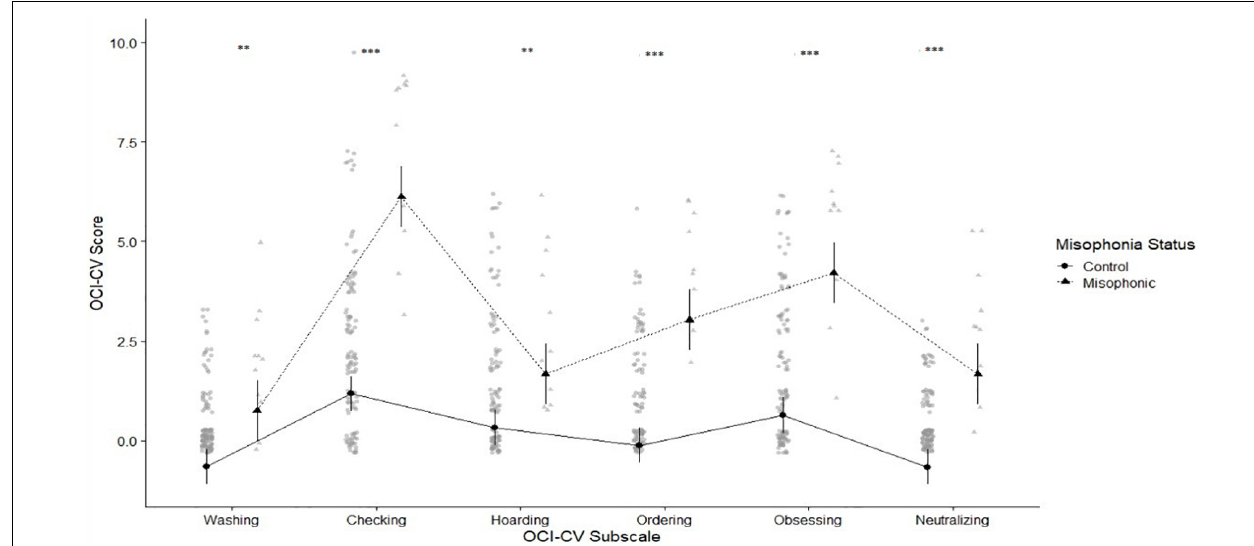
FIGURE 2 | Means plot showing greater scores for misophonics (shown in triangle) and controls (shown in circles) in each of the OCI subscales (from left to right: Washing , Checking and Doubting , Hoarding , Ordering , Obsessing , and Neutralizing ). Here and in all similar figures, means are shown with black circles/triangles, while grey points represent the raw data, with overlapping points appearing darker. Here and throughout, error bars show 95% confidence intervals, and the asterisks represent significant p values as follows: ∗ < 0.05, ∗∗ < 0.01, and ∗∗∗ < 0.001. TABLE 2 | Spearman Correlations between misophonia scores and our remaining measures ( r and p values) with 95% confidence intervals. Correlation with SMS-A (misophonia) 95% CI Subscale r value p